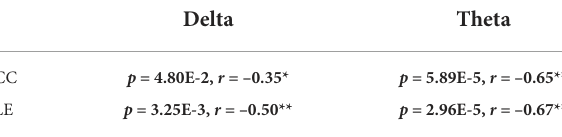
TABLE 4 Pearson correlation analysis results between local measures and decision accuracy in delta and theta bands.